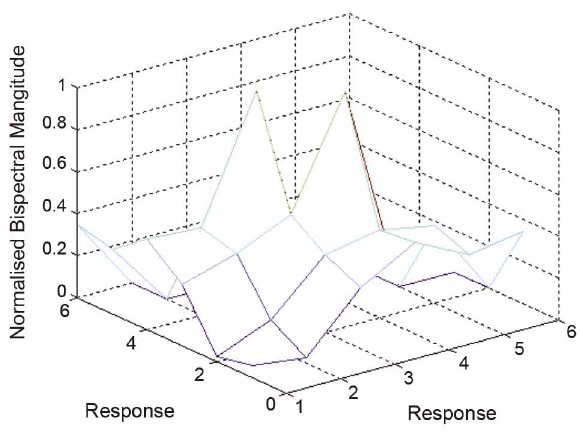
Fig. 2. Bispectrum of major sources of construction